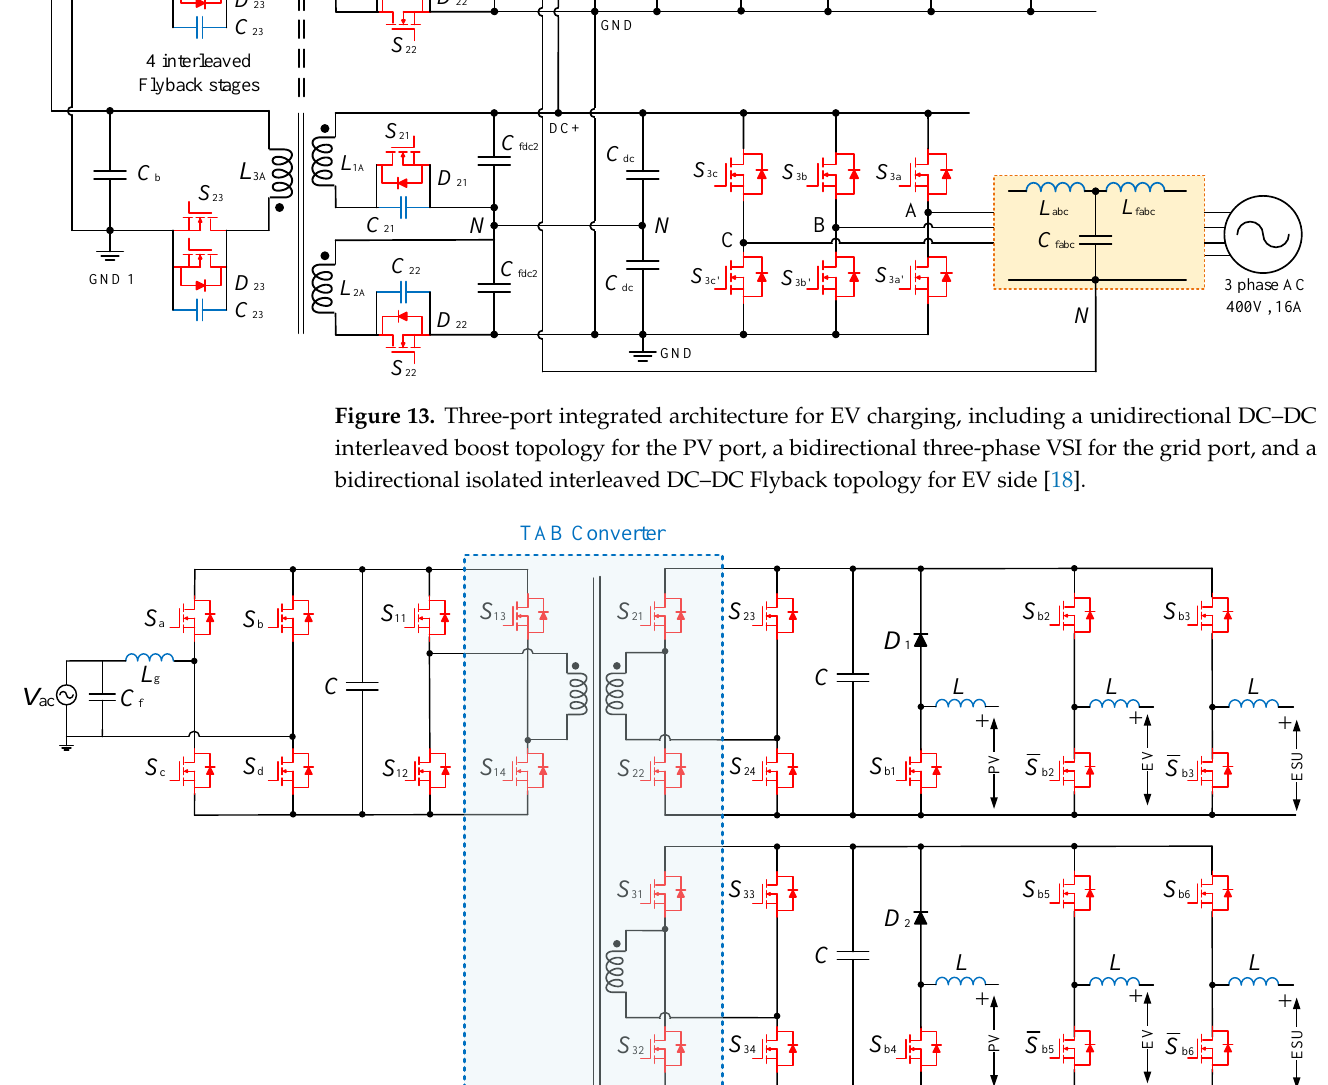
Figure 14. Four-port integrated architecture for EV charging, including a triple active bridge (TAB) converter, a bidirectional DC–DC converter interfacing the EV battery, a DC–DC unidirectional boost converter for PV port, and a bidirectional grid-interfaced converter [88]. A three-port integrated topology based on interleaved Boost and DAB converters has been proposed in [89]. As shown in Figure 15, the DAB topology interfaces with the grid (Port-3) while the interleaved boost converter interfaces EV (Port-1) and PV (Port-2). Apart from a simple and compact design, the modulation technique used does not require com- plex control or optimization. Furthermore, the proposed architecture offers high power density and can be scaled up to higher power. Despite inherent soft-switching for the DAB converter, the interleaved Boost converter suffers from hard switching, plus a large output filter is required to secure low THD.